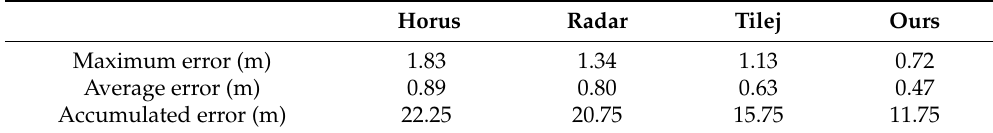
Table 1. Localization error of the four methods.